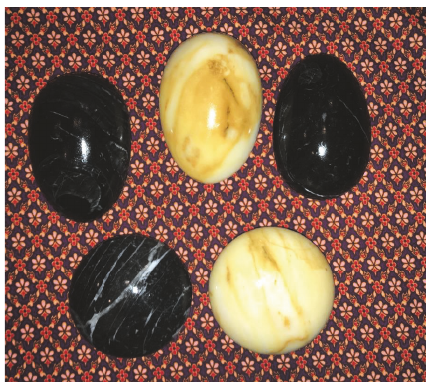
Figure 3: A hot stone therapy which is a part of traditional Thai postpartum practices is believed to promote uterus involution and help to heal perineal tears in postpartum